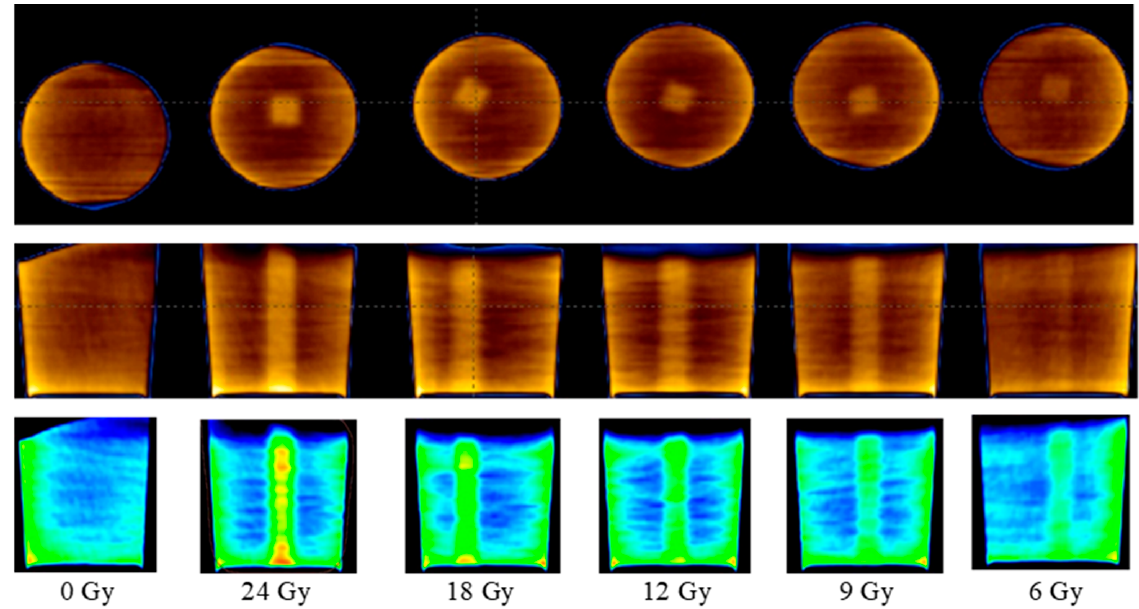
Figure 2. CT scans of irradiated polymer gels samples without and with colored indication of optical density changes (bottom row).